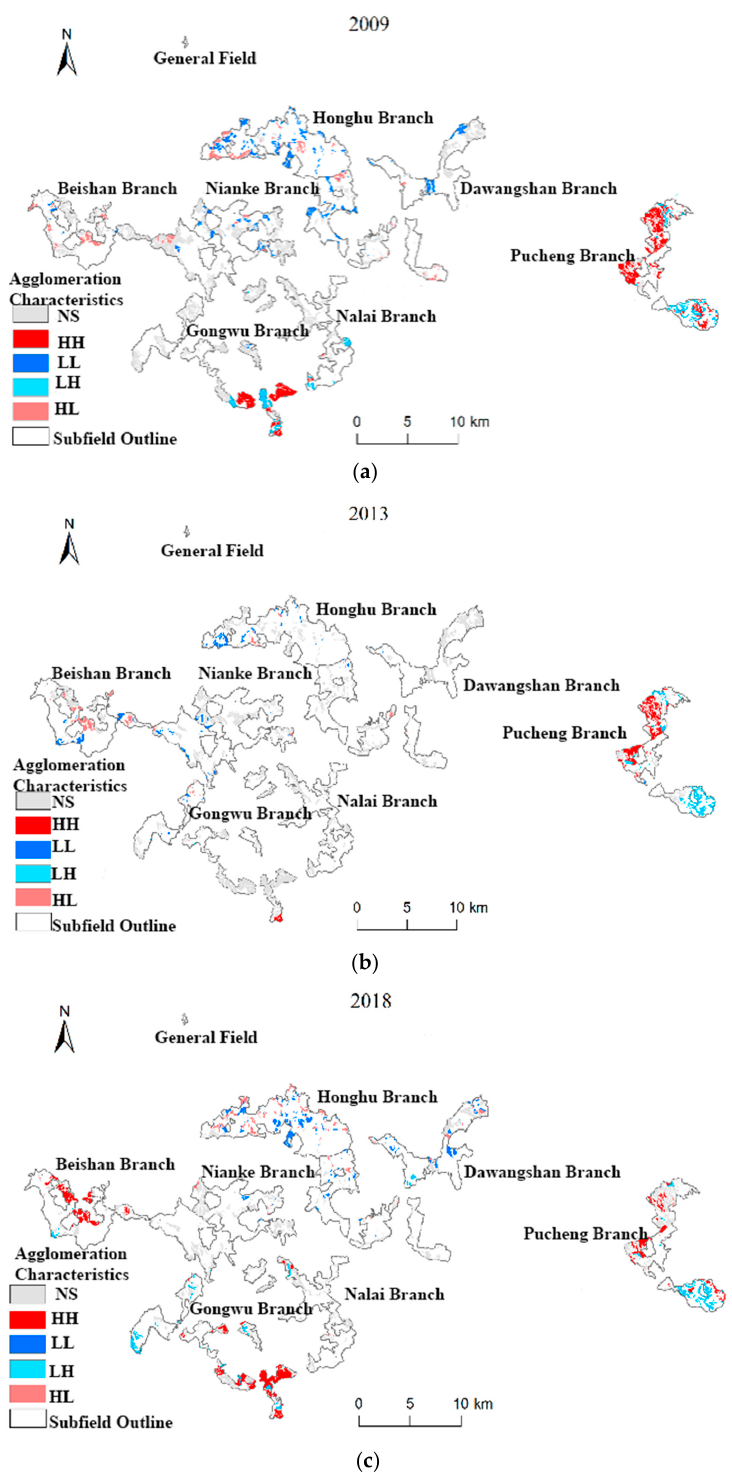
Figure 5. The Local LISA map shows the relationship between wood supply and water conservation services in PM plantations in Paiyangshan Forest Farm from 2009 to 2018. The map is categorized into NS (not significantly clustered), HH (high–high clustering), LL (low–low agglomeration), LH (low–high agglomeration), and HL (high–low agglomeration). We present three LISA maps: ( a ) the map of wood supply and water conservation services in 2009, ( b ) the map of wood supply and water conservation services in 2013, and ( c ) the map of wood supply and water conservation services in 2018.